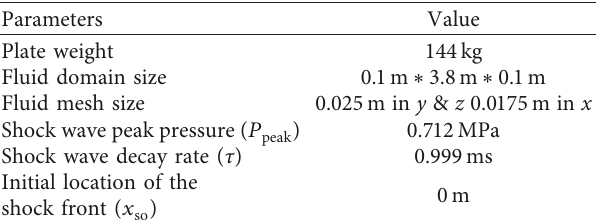
Figure 4: Time-step interpolation.